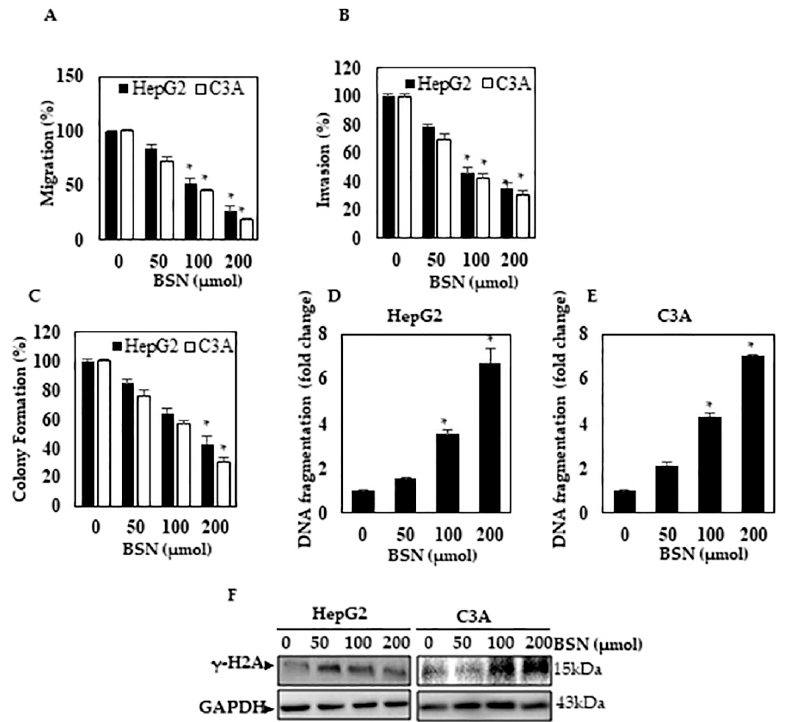
Figure 2. DNA fragmentation from BSN inhibited migration, invasion, and colony formation. ( A ) For 24 h, the indicated concentrations of BSN were applied to C3A and HepG2 cells. Migration assays were used to test the wound-healing ability of HepG2 and C3A cells (Original magnification, × 100). ( B ) The invasiveness in each sample was determined by counting three microscopic fields. Cell invasion inhibitory percentage was calculated and expressed as 100% for untreated cells (control). ( C ) BSN interfered with colony formation (HepG2 and C3A cells). In the presence of BSN (0–200 µ mol), the cells were incubated for five days to observe if they would proliferate or form colonies. Calculated